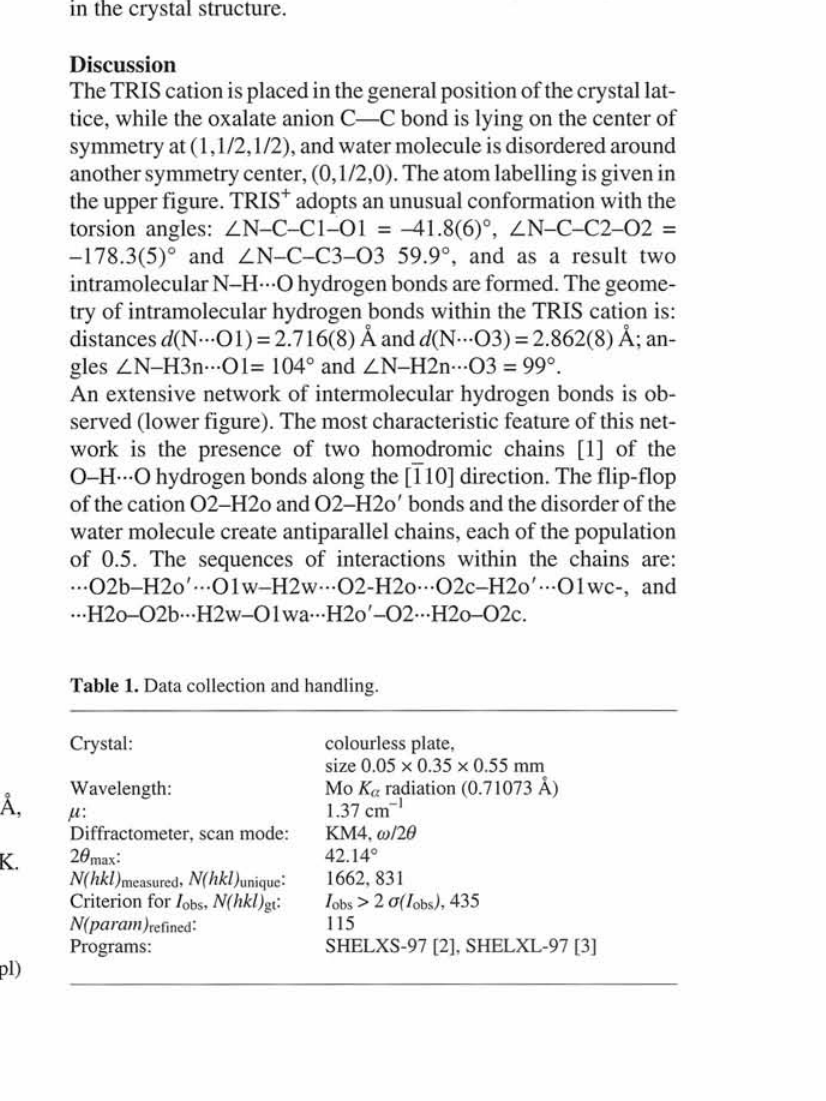
Table 1. Data collection and handling.